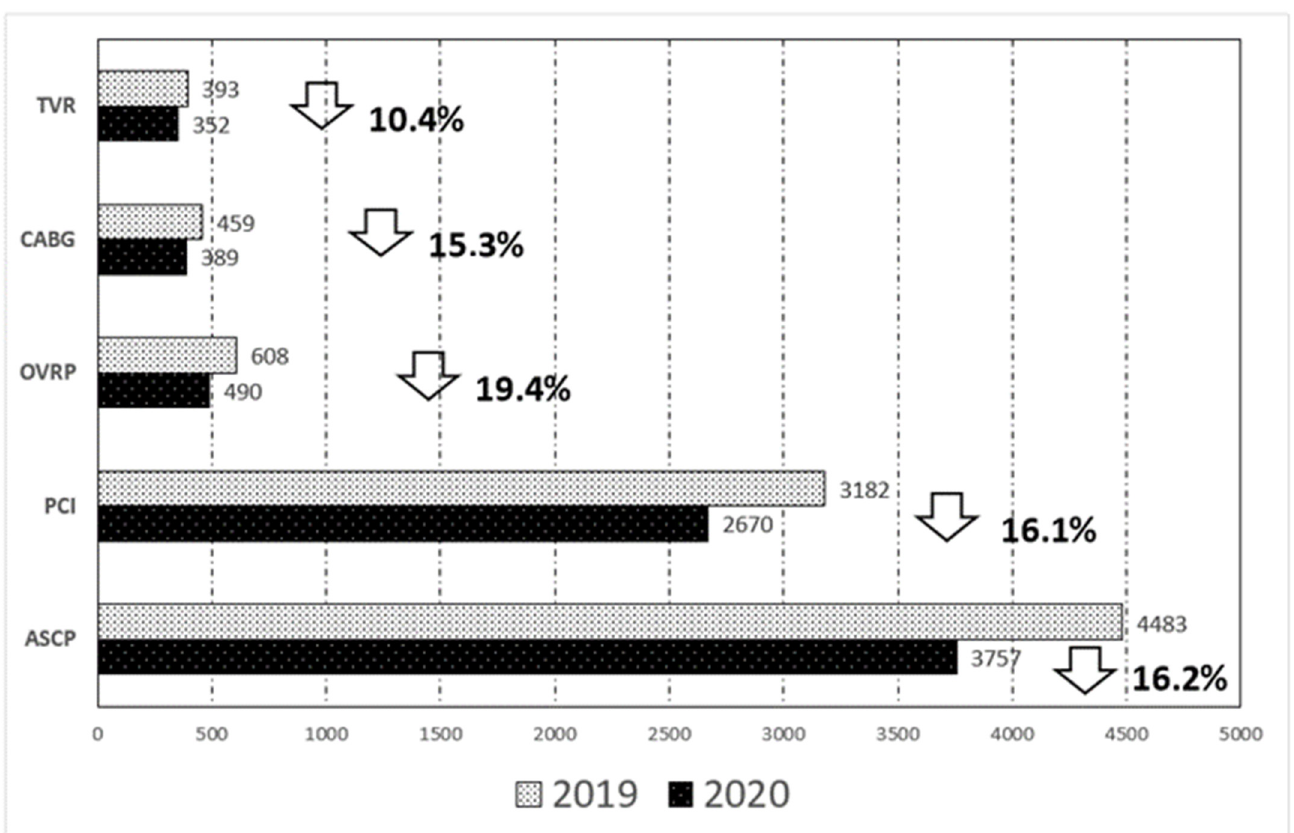
Figure 1. Number of cardiac procedures in patients with chronic obstructive pulmonary disease and the proportional change in “any cardiac procedure”, percutaneous coronary intervention, open valve replacement procedures, coronary artery bypass graft, and transcatheter valve replacement from 2019 to 2020. ASCP: Any cardiac procedure; PCI: Percutaneous Coronary Intervention; OVRP Open Valve Replacement Procedures. CABG: Coronary Artery Bypass Graft; TVR: Trans Catheter Valve Replacement.